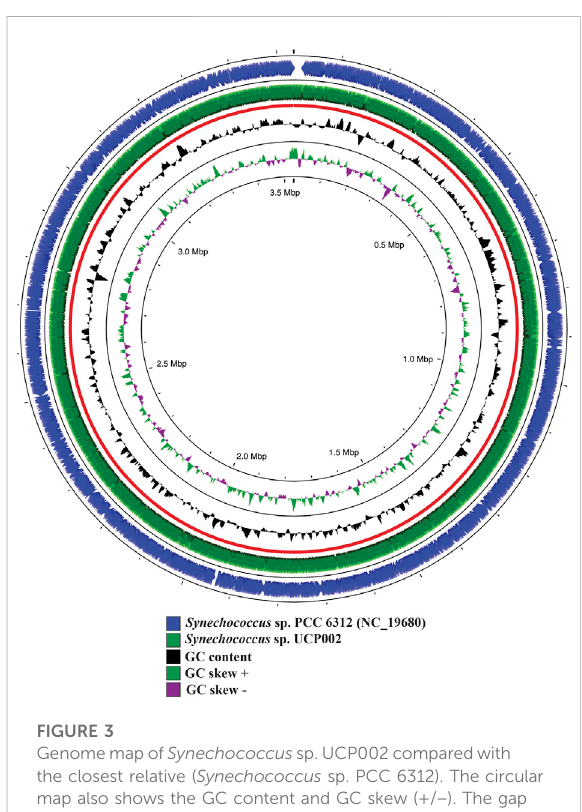
FIGURE 3 Genomemapof Synechococcus sp.UCP002comparedwith the closest relative ( Synechococcus sp. PCC 6312). The circular map also shows the GC content and GC skew (+/ − ). The gap regions show no overlapping regions with the closest neighbor.